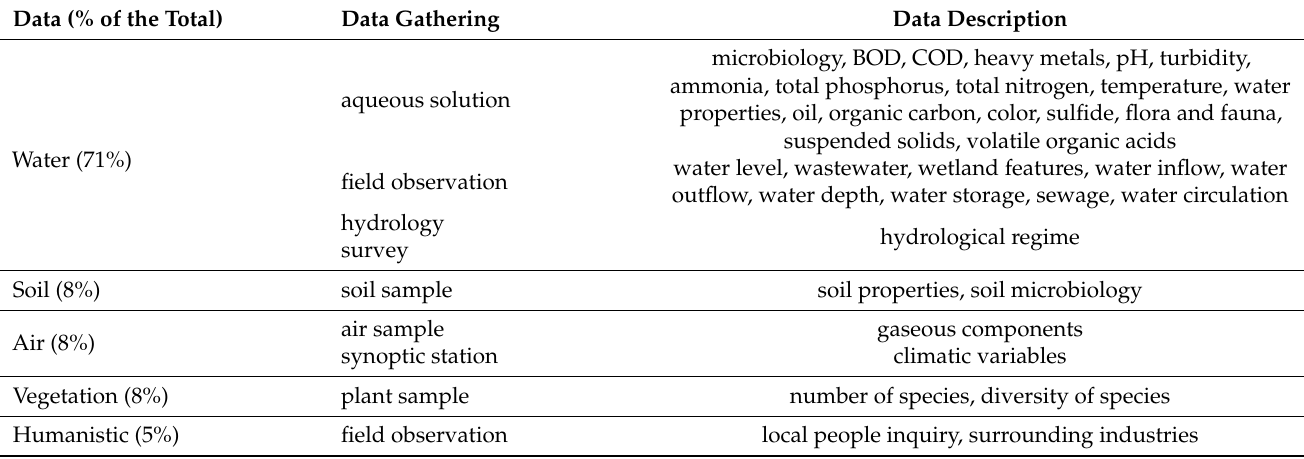
Table 3. Summary of data required to identify wetland odor based on the class